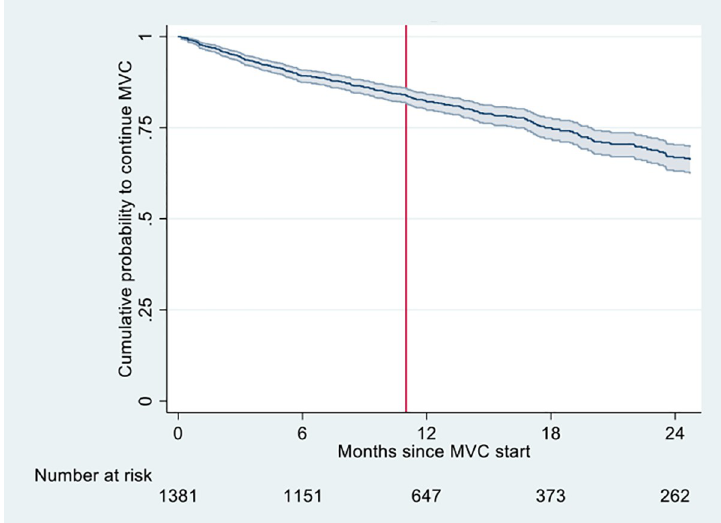
Fig 1. Kaplan-Meier curve of the cumulative probability of continuing maraviroc after its initiation in the study cohort. The line indicates the estimate, shadows represent the 95% confidence intervals. MVC, maraviroc. The number of patients receiving maraviroc are indicated as “Number at risk”. The vertical line shows the 48 weeks cut-off point; all available data up to 24 months of follow-up were